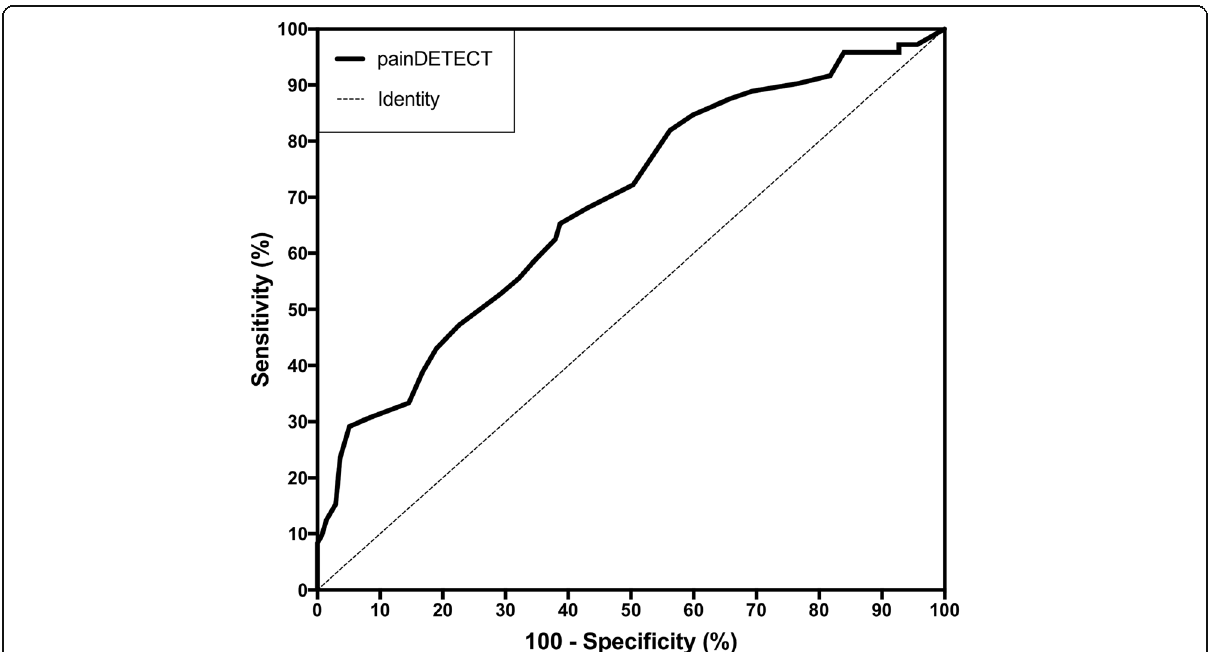
Fig. 2 AUROC analysis of the PD-Q for detecting neuropathic pain components in the cohort. The AUC is compared to that of an identity line, with an area of 0.5. The difference in areas between the curve and the identity line was significant ( p =